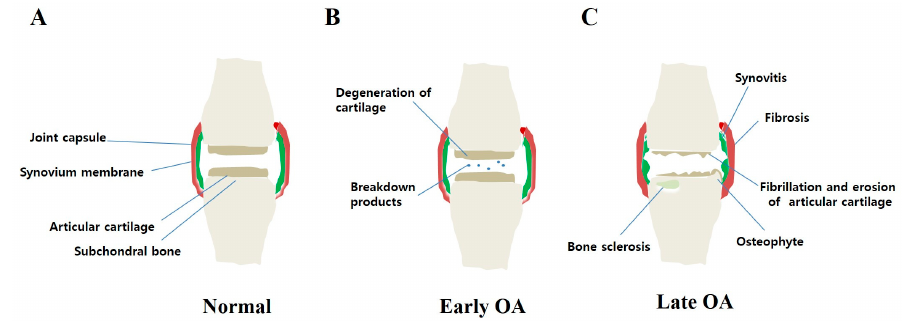
Figure 1. Model of pathologic progression of osteoarthritis (OA). OA is a slow, progressive disease. ( A ) Normal joint without any damages; ( B ) Early OA is always difficult to detect, characterized by cartilage degeneration and release of breakdown products into the synovial fluid environment; ( C ) Late OA is an obvious event, with cartilage loss (fibrillation and erosion of articular cartilage) and osteophyte formation. Damage of the subchondral bone, synovium and capsule may also occur (bone sclerosis, synovitis, and fibrosis,